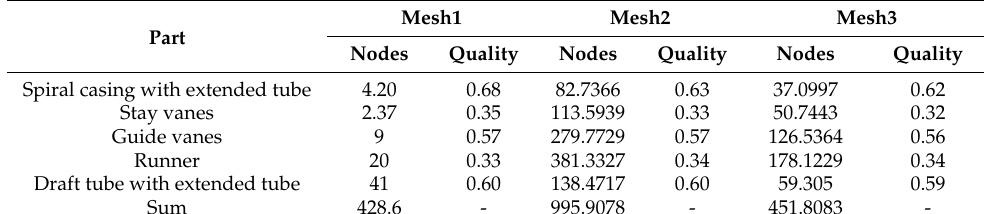
Table 2. Details of three sets of grids.